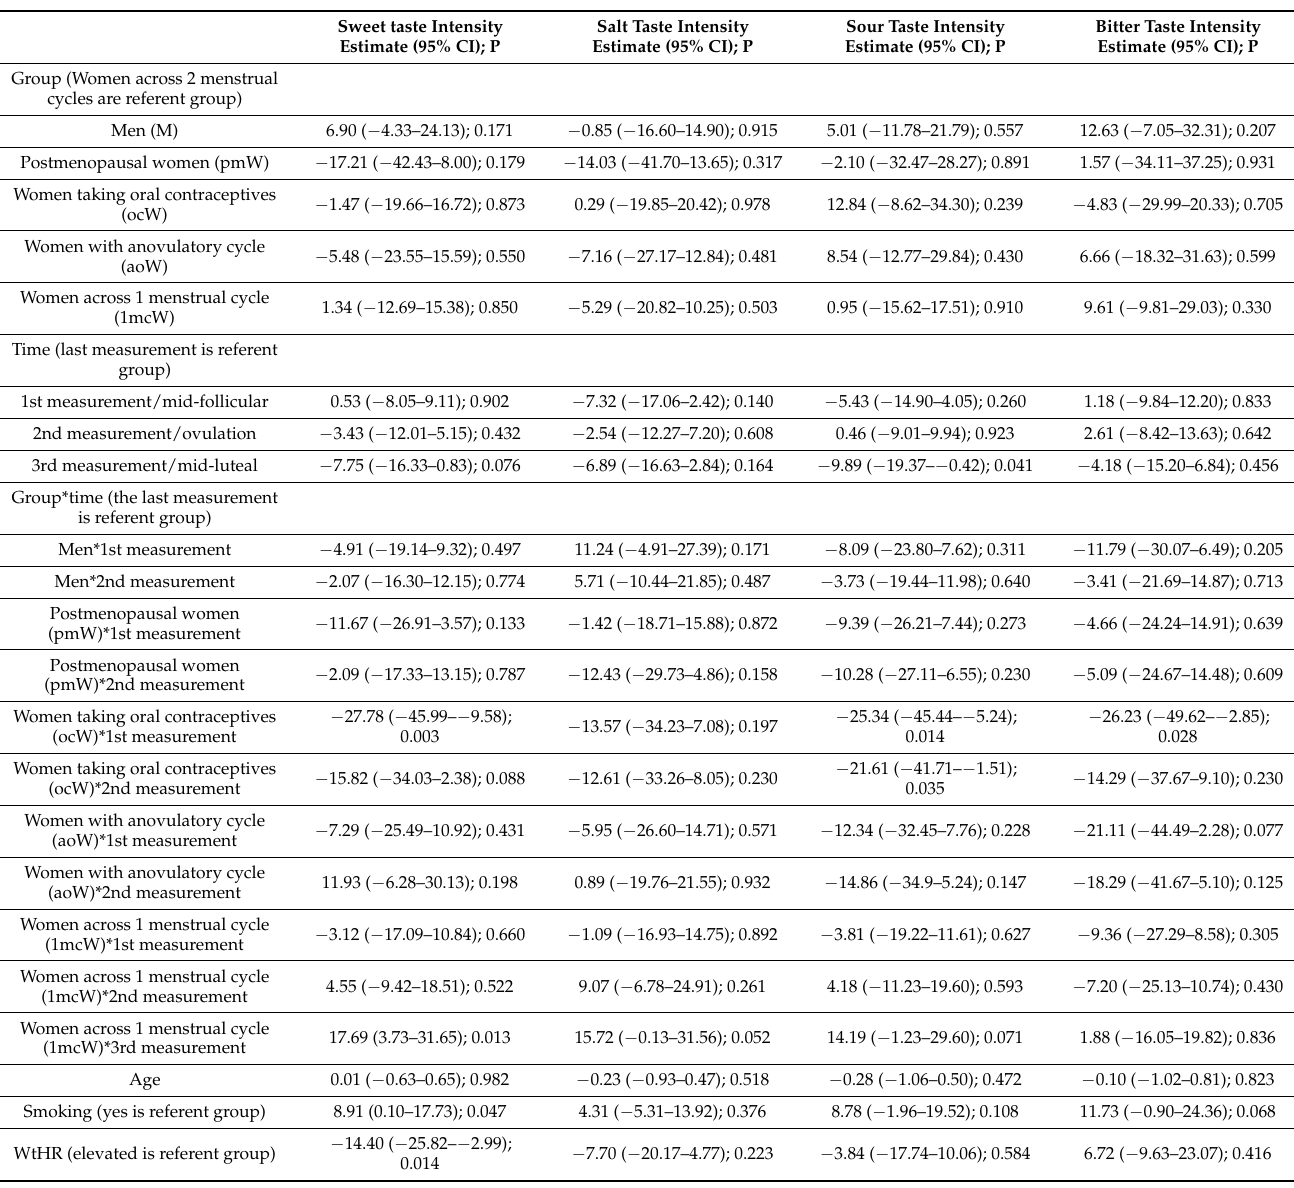
Table 5. Differences in gustatory intensity perception across study groups and measurements or menstrual cycle phases, using linear mixed models controlled for age, smoking, and waist-to-height ratio.